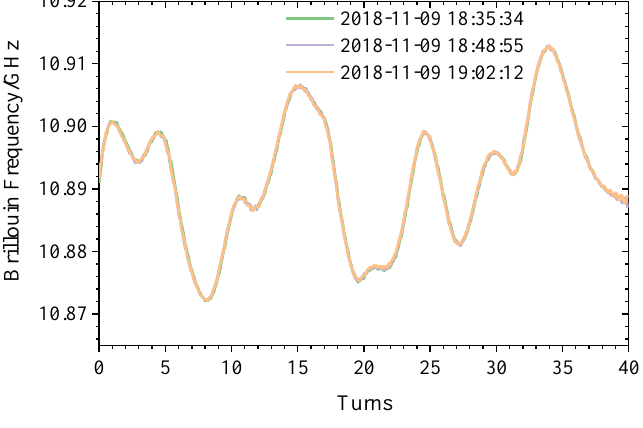
Sensors 2019 , 19 , x FOR PEER REVIEW Figure 9 . Winding original frequency shift. Figure 9. Winding original frequency shift.